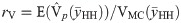
For the simulated population, bias index of the sampling variance estimator as a function of the nonresponse rate at the last phase.Curve of the bias index rV=E(V^p(y¯HH))/VMC(y¯HH) based on 1 000 000 simulations of the nonresponse mechanism, for πz = 0.2, πm(1) = 0.85, and πm(2) = 0(0.1)0.9. Details in the text.